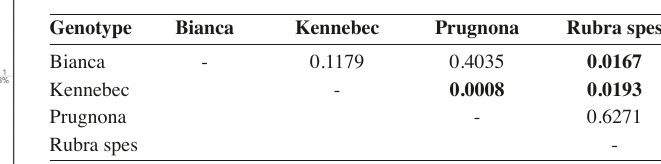
Tab. 3: P -values returned by pairwise MANOVA performed on the Fourier coefficients of the tuber shape of each potato genotype. P -values < 0.05 are highlighted in bold.